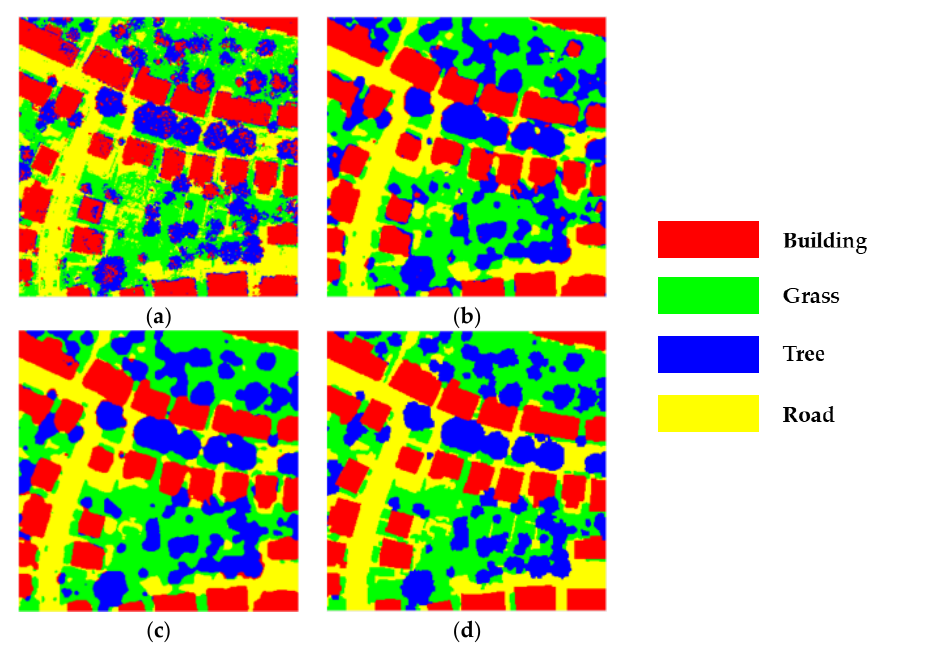
Figure 11. The land cover map of test set 1: ( a ) DS; ( b ) F-DS-FH; ( c ) the proposed method P-DS; ( d ) ground truth.